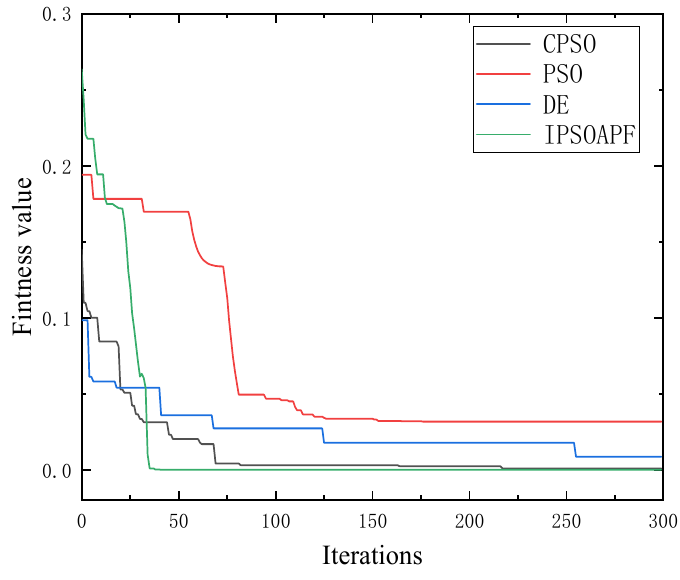
Figure 7. Iterative process of each algorithm.